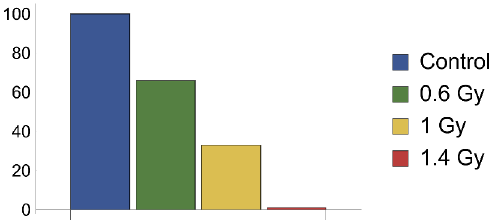
Figure 4. Percentage of the pattern retrieval success calculated from network activity after radiation- induced damage caused by 600 MeV / u iron ions with di ff erent doses